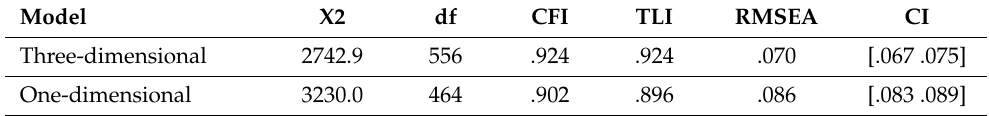
Table 7. Goodness of fit indices for testing dimensionality of the construct under investigation. Model Three-dimensional One-dimensional